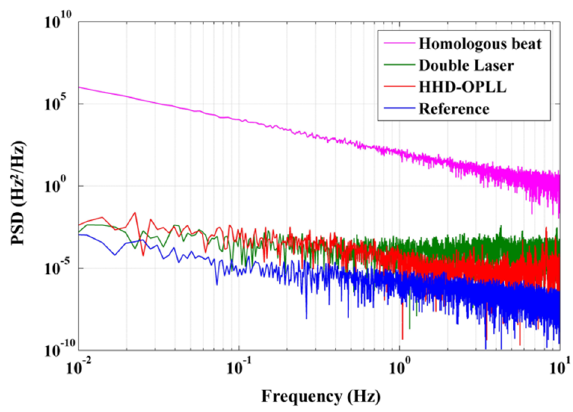
Figure 8. Power spectral densities (PSDs) of beat frequency noises under various conditions.